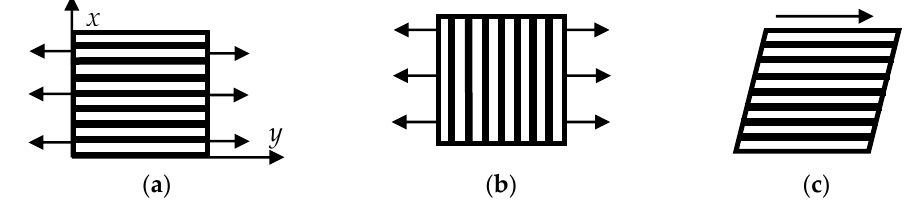
Figure 11. The schemes of composite-impregnated CF layers under tension: ( a ) along CF; ( b ) across CF; ( c ) shear along CF.